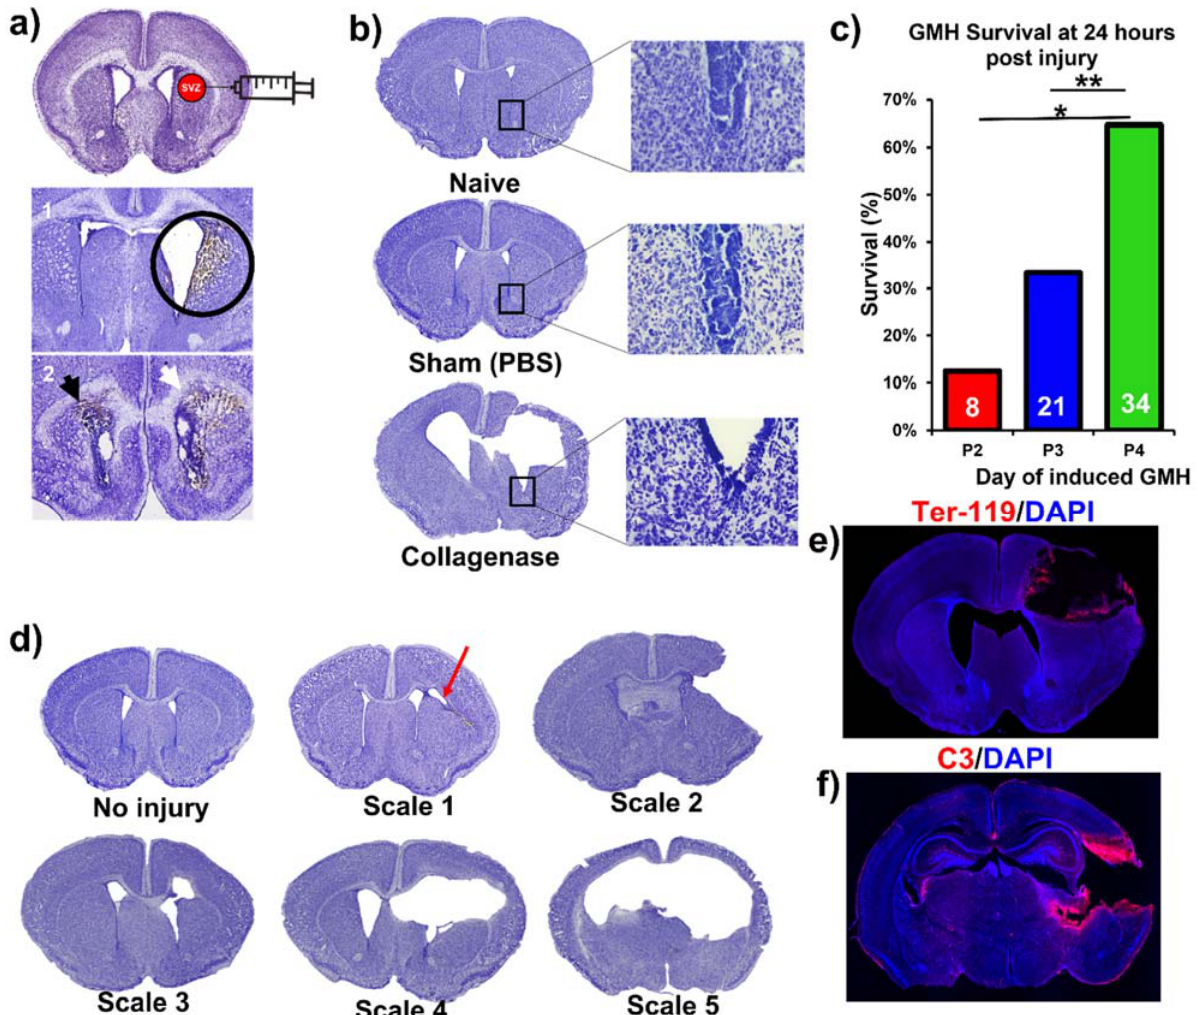
Figure 2. Collagenase-induced intraparenchymal GMH results in lesion coupled with hydrocephalus and hemorrhage within the SVZ. ( a ) Nissl-stained images demonstrating the collagenase injection site and showing blood product deposition within surrounding tissue in both ipsilateral and contralateral ventricles as labeled by the black and white arrowheads. ( b ) Nissl stains of naïve, sham, and vehicle brains (showing hydrocephalus), with magnified images of the lower tip of the ventricle. ( c ) Survival at 24 h after collagenase injection in pups at P2, P3, or P4. Two separate Chi-square tests were performed, one between P2 and P4, and the other between P3 and P4. * p < 0.05, ** p < 0.01. ( d ) Nissl image examples of different injury scales (0 to 5) used to categorize injury severity. ( e ) Representative IF staining of red blood cells (Ter-119 in red) and cell nuclei (DAPI in blue) in an injured P7 animal brain (3 days after injury) with deposition of blood products along the lesion. ( f ) Representative IF staining of complement deposition (C3 in red) and cell nuclei (DAPI in blue) in an injured P7 animal brain (i.e., 3 days after injury) showing extensive perilesional C3 deposition. No data points were excluded from the analysis.